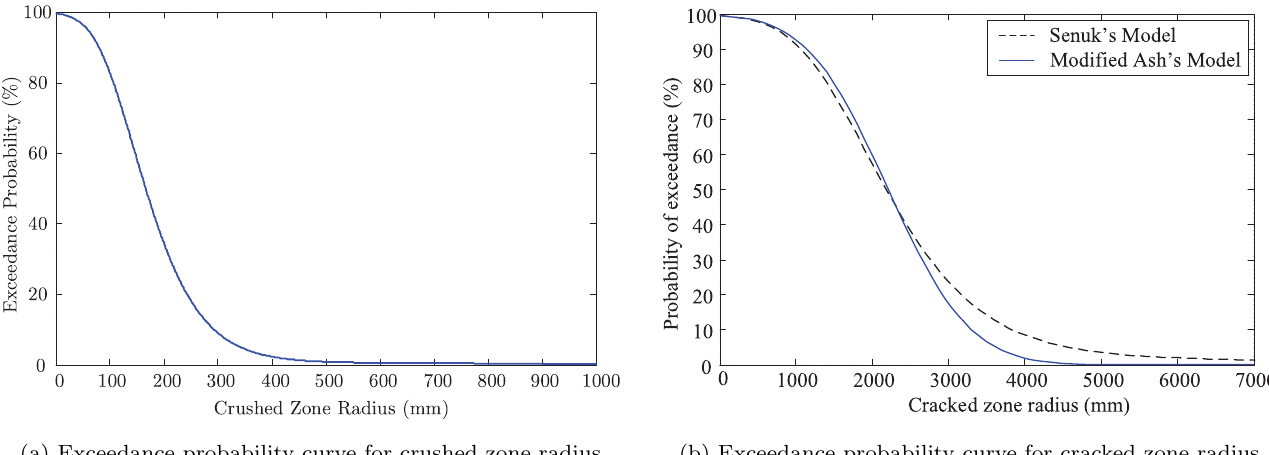
(b) Exceedance probability curve for cracked zone radius Figure 3. Exceedance risk curve calculated by FORM. (a) Exceedance probability curve for crushed zone radius Figure 1: Histogram of generated random samples for (a) H , (b) H , (c) L , and (d) δ . Figure 8. The exceedance probability curve for ( a ) crushed and ( b ) cracked zones. Figure 5. Exceedance probability versus (a) crushed zone radius and (b) cracked zone radius for di ff erent models. e t R max The diagram was then drawn for all the points in the vicinity of the blast location and presented as exceedance probability contours (Figure 9). Table 7. Exceedance probability for Senuk ’ s and modi fi ed Ash ’ s models.